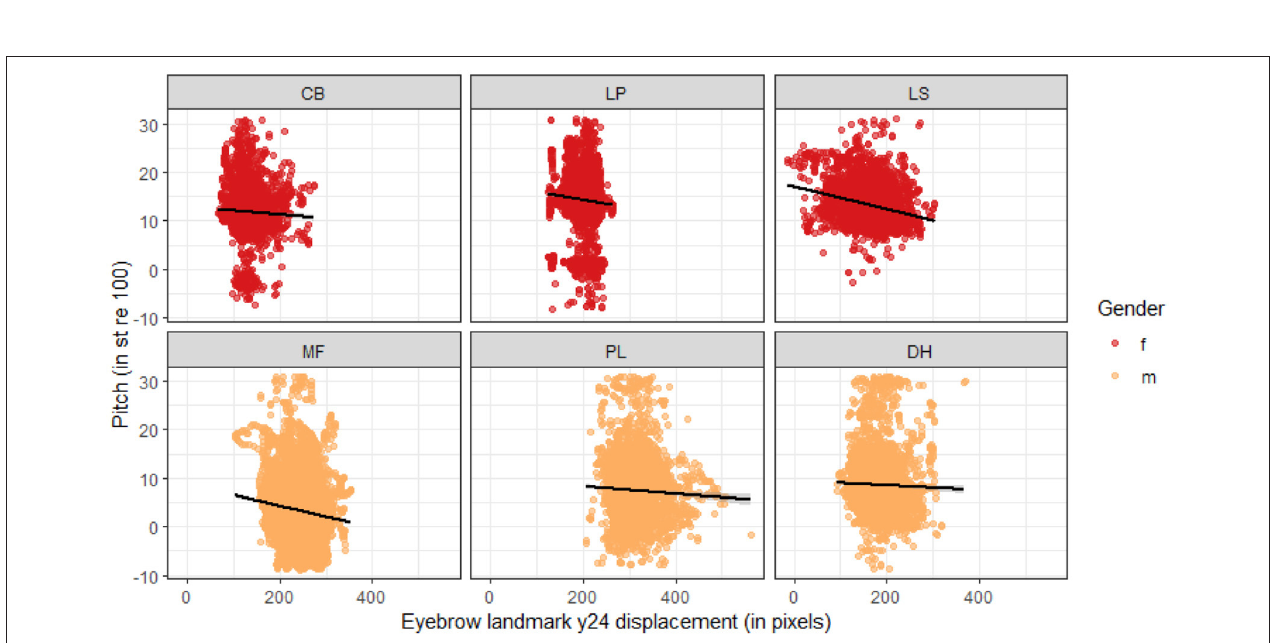
FIGURE 5 | Correlations between pitch (in semitones) and the displacement of the eyebrow landmark y_24 (middle landmark on rightmost eyebrow, in pixels) for each of the six speakers. Negative correlations correspond to a raising of the eyebrow landmark as pitch increases: The y-coordinates have lower values the higher the landmark is in the video frame, and thus the